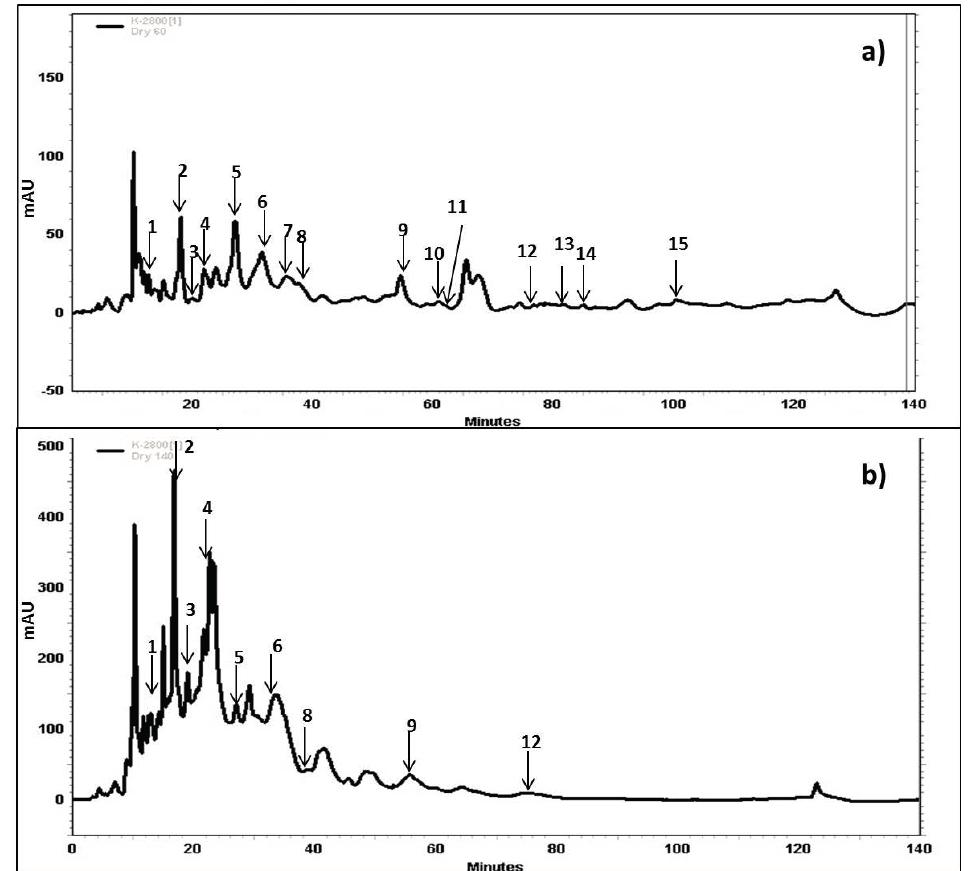
Figure 5. Representative HPLC chromatograms of phenolic compounds extracts of dry grape pomace obtained at 60 °C (3.9 g GAE/100 g DM) ( a ) and 140 °C (7.3 g GAE/100 g DM) ( b ) detected at 280 nm UV wavelength. Peaks: 1, Gallic acid; 2, Protocatechuic acid; 3, Prodelphinidin B3; 4, Gallocatechin; 5, 4-Hydroxybenzoic acid; 6, Catechin; 7,